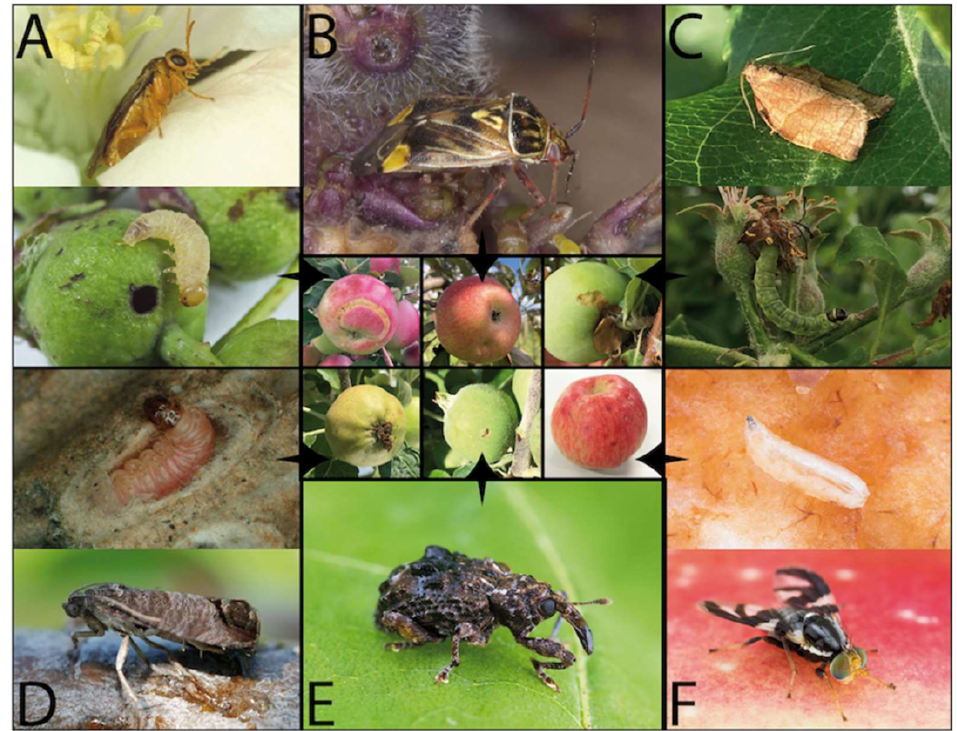
Figure 1. ( A ) European apple sawfly (adult and larva); ( B ) tarnished plant bug (adult); ( C ) oblique- banded leafroller (adult and larva); ( D ) codling moth (adult and larva); ( E ) plum curculio (adult); ( F ) apple maggot (adult and larva); at the centre: fruit damage caused by these insects. Photos: F. Pelletier (1 A , damage; 1 B , damage; 1 C , adult and larva; 1 D , damage); F. Vanoost- huyse (1 B , adult; 1C , damage; 1 D , adult and larva); A. Charbonneau (1 E , damage);